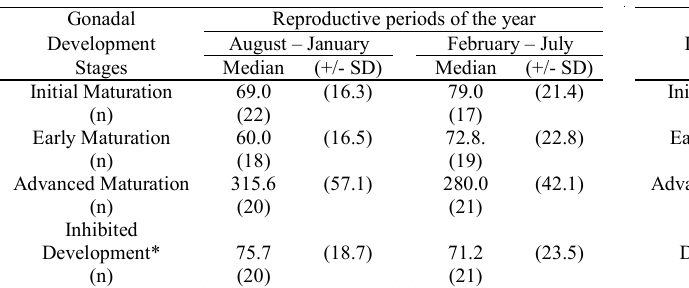
Table 3. Mean concentration (pg/ml) and standard deviation (+/- SD) of 17 beta-estradiol in non-infested males of Cypho- charax gilbert in different gonadal development stages and in infested.